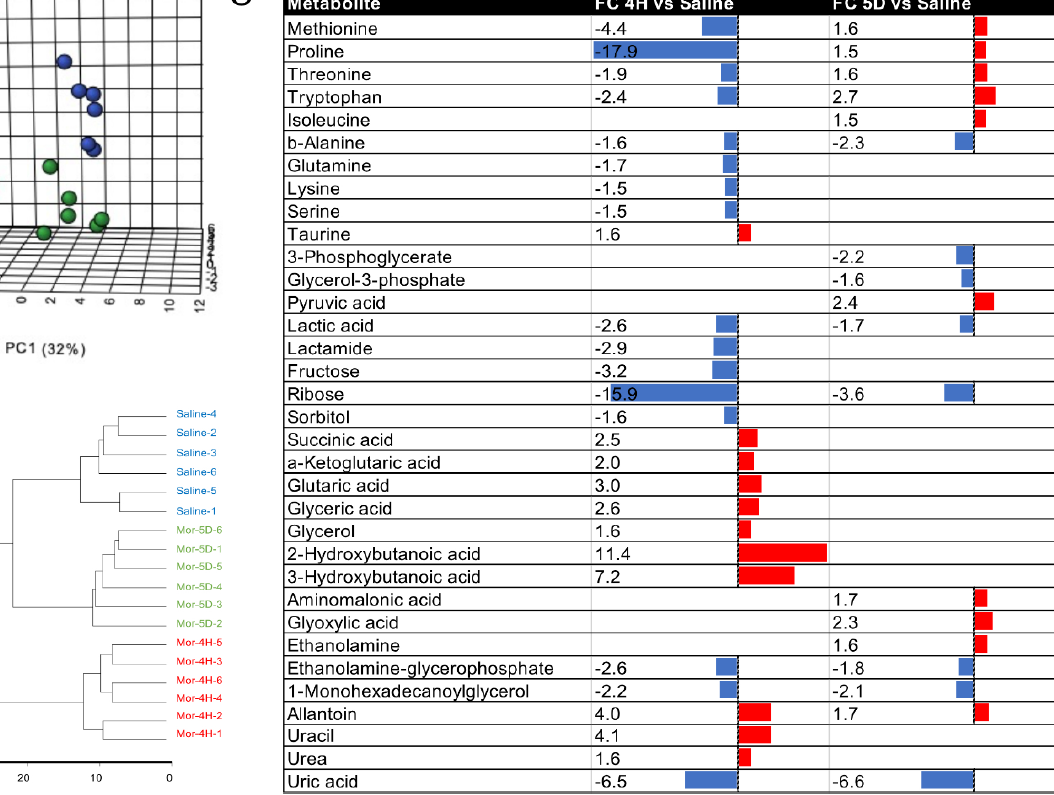
Figure 2. Acute or chronic morphine intake is associated with distinct plasma metabolic signatures. ( A ) Principal component analysis of metabolic profiles detected with GC – MS in mouse plasma after acute, 4 h (Mor 4H), chronic, 5 days (Mor 5D), or after saline (Saline) injection of morphine; ( B ) hierarchical clustering of metabolic signatures in distinct mice groups; ( C ) univariate analysis of significant metabolic changes occurring in mouse plasma after acute (4H vs . Saline) or chronic (5D vs . Saline) intake of morphine in tolerant mice. Metabolites were considered significant for p -values < 0.05 in significance t- testing (2-tailed, heteroscedastic), and absolute fold change (FC) > 1.5; red bar: upregulation, blue bar: downregulation.